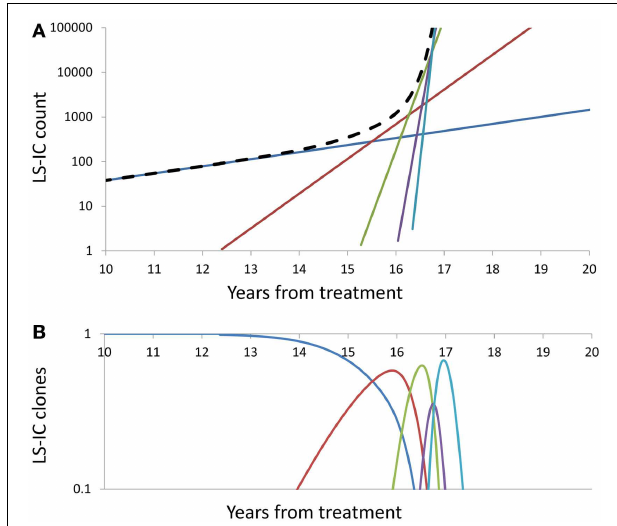
FIGURE 3 | Summary of successive driver mutations in the natural course of the SCN → sMDS → sAML transition. (A) Counts N i ( t ) of cells in successive mutant clones, under model as in Eq. 7 with A = 0.02, ε = 0.2, and k = 2. Straight lines with increasing slopes: counts of cells in successive mutant clones.Thick dashed line:Total mutant cell count. (B) Relative proportions n i ( t ) = N i ( t )/ Σ j N j ( t ) of cells belonging to successive mutant clones. Further details as in the Section “Mathematics of the Model.”